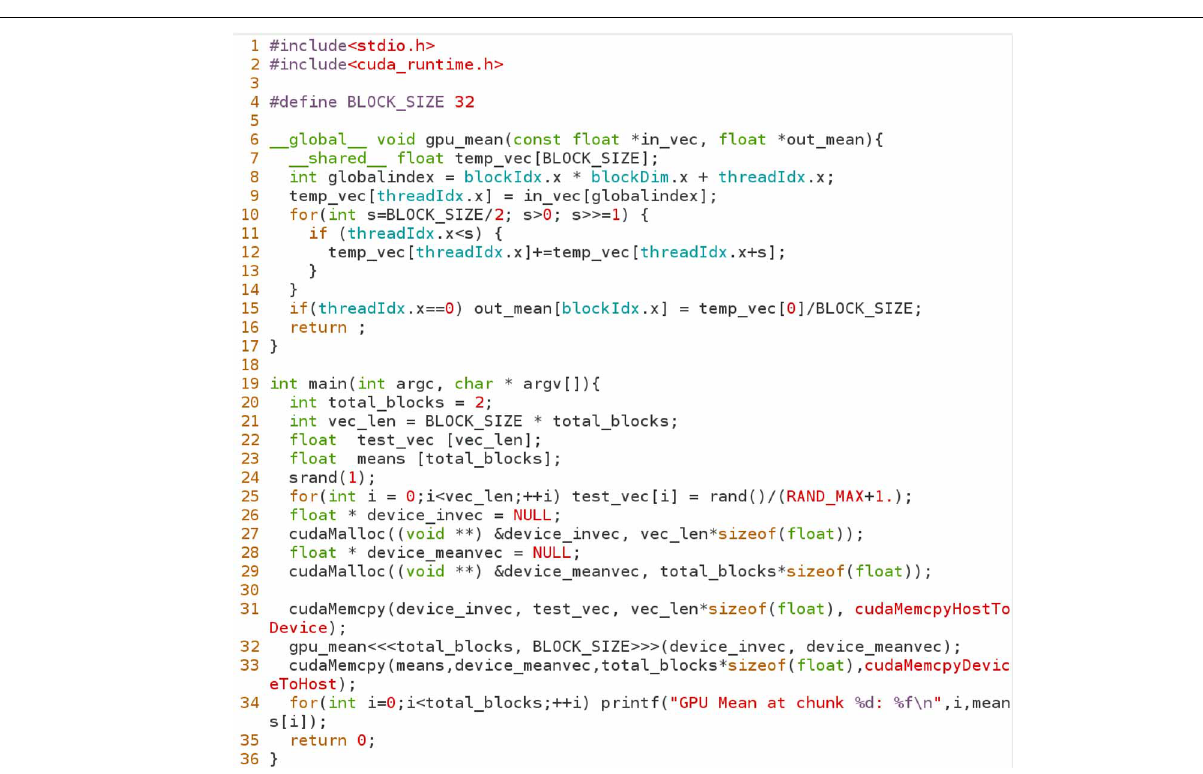
FIGURE A3 | CUDA code for computing means across different